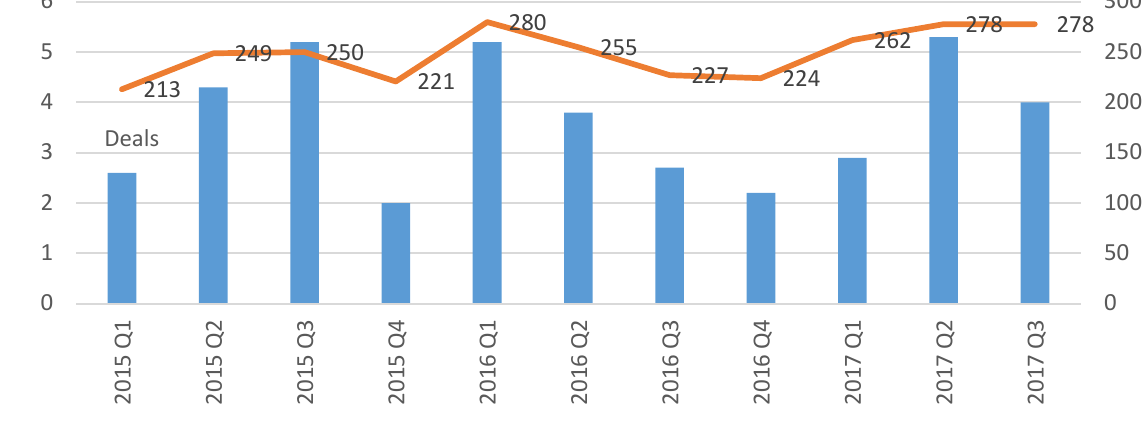
Figure 1. Global investment in new financial technology, in USD